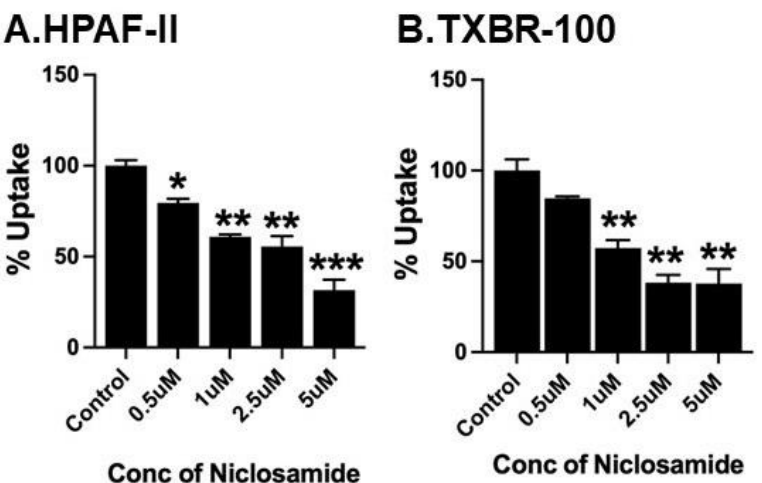
Figure 6. Direct effect of niclosamide on SLC38A5-mediated serine uptake. Uptake of [ 3 H]-serine